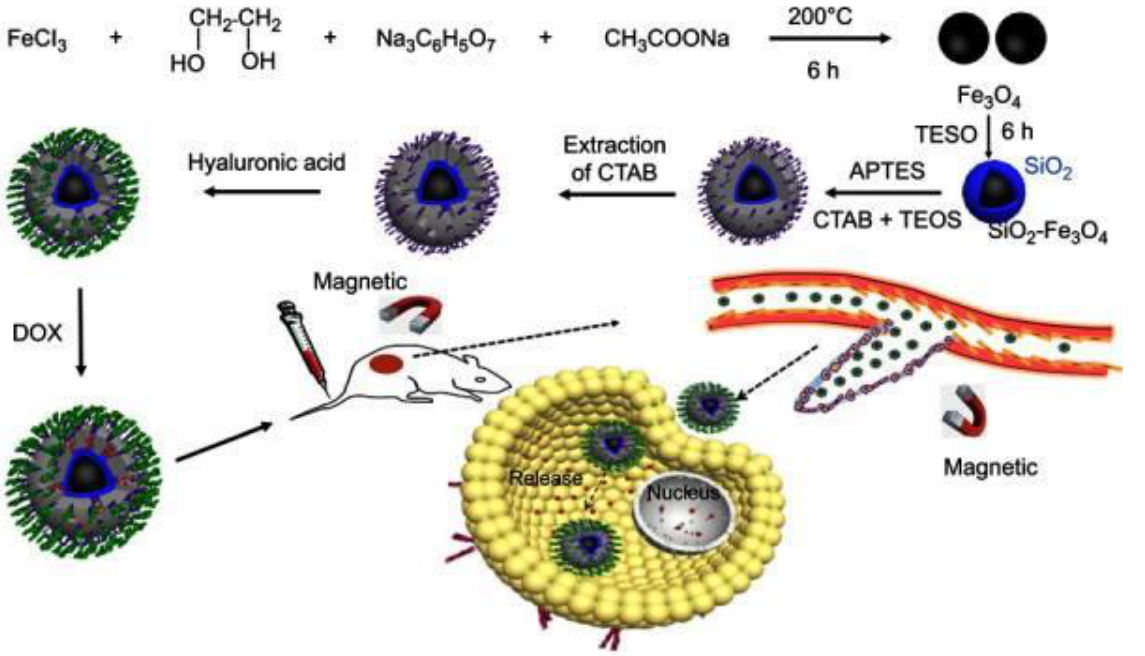
Figure 11. A proposed creation of HA-MSNs for targeted cancer treatment in vivo and pH-responsive drug release following specific binding with cancer cells. Adapted from Fang et al. [95].